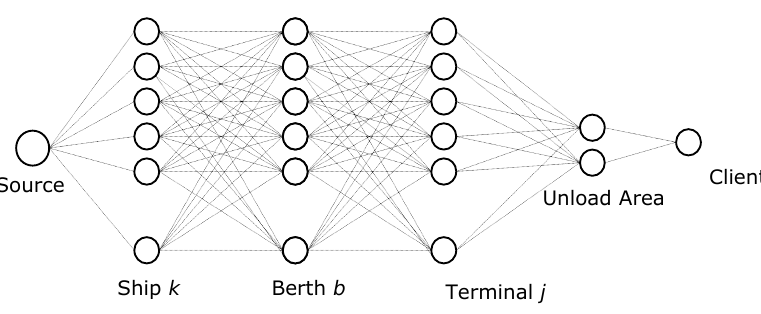
Figure 2. “Containers Allocation in Maritime Terminals”.